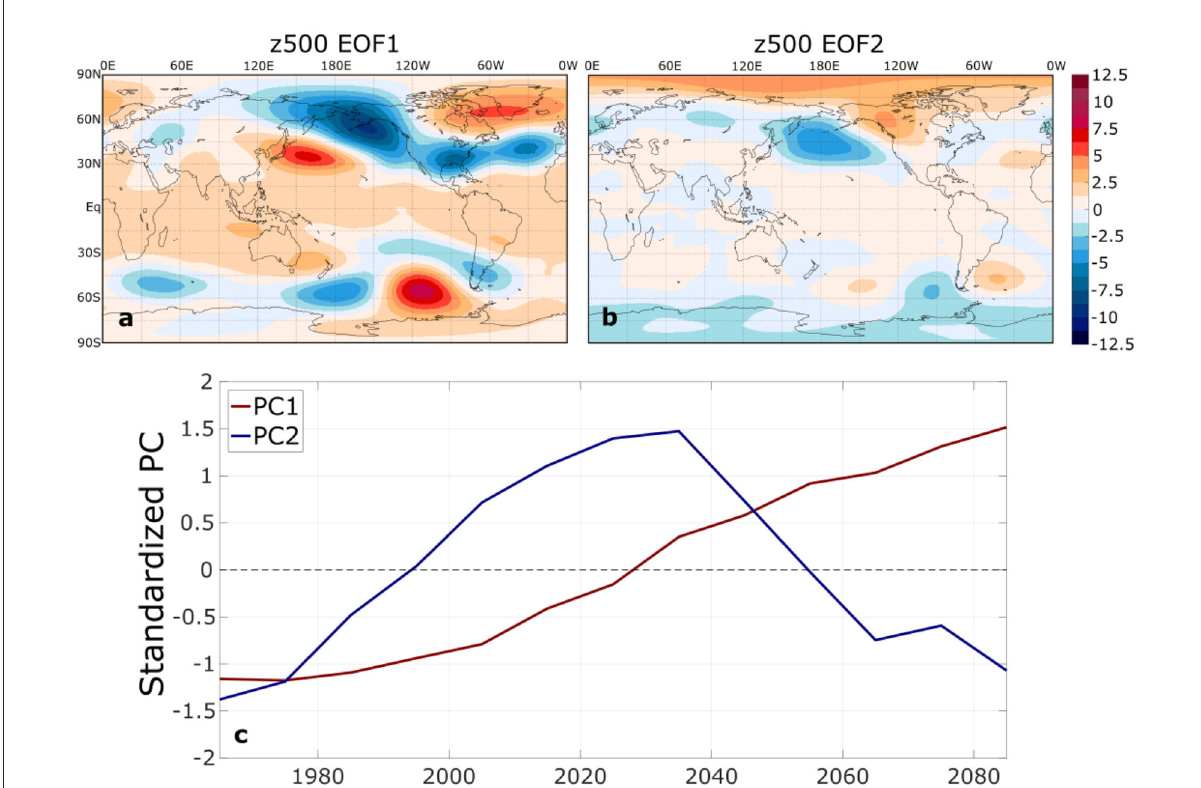
FIGURE5 The (a) first and (b) second empirical orthogonal functions (EOFs) of Northern Hemisphere DJF ensemble mean El Niño z500 composite anomalies, expressed as linear regressions on the standardized principal components (m). The leading EOFs explain 74.3% and 16.6% of the temporal variance of 30-year ensemble-mean El Niño composites of Northern Hemisphere z500. (c) The time series of the corresponding principal components (PCs). In (c) , the year is assigned to the middle of the 30-yr composite period (e.g., 1965 for the 1951–1980 composite